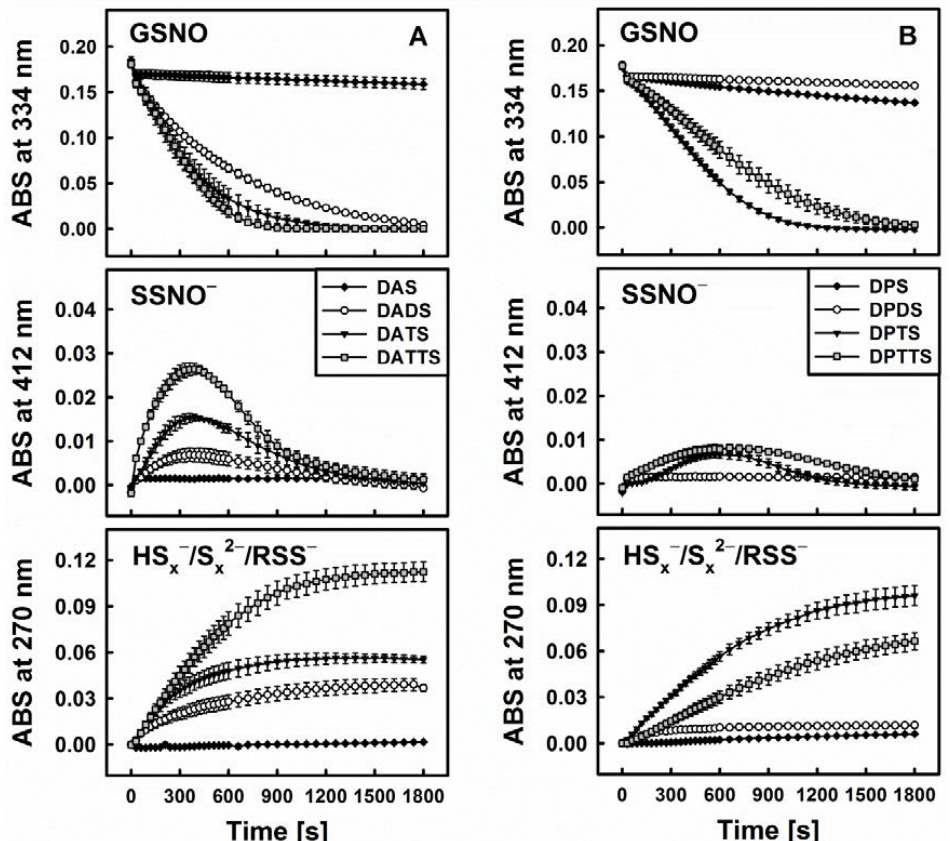
Figure 4. Kinetic traces of the interactions of sulfanes (200 µM) of different sulfur-sulfur chain lengths (from 1 to 4) with GSNO in the presence of 800 µM Cys monitored at three characteristic wavelengths by UV/VIS spectrophotometry. Allyl compounds characteristic of garlic ( A ) and propyl analogues characteristic of onions ( B ) ( n = 3).